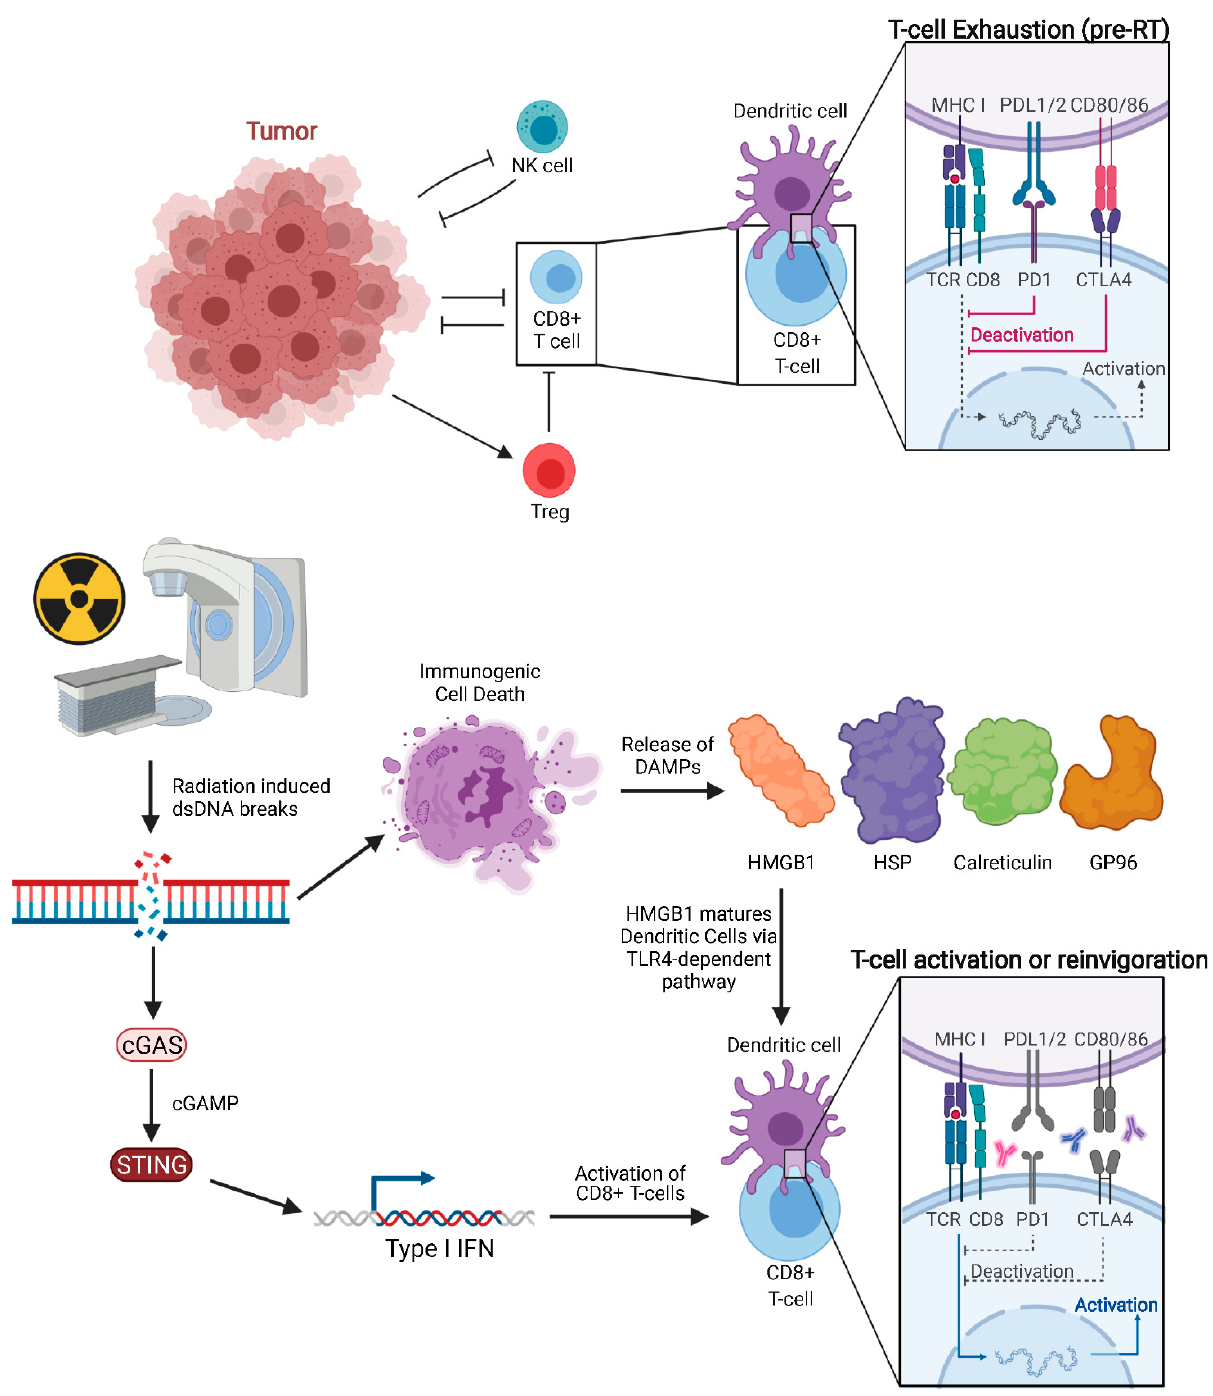
Figure 2. Pre-treated tumor with exhausted CD8 + T cells and tumor proliferating without immune inhibition. Radiation of tumors leads to double-stranded DNA breaks and downstream cGAS-STING signaling, which in turn increases Type 1 IFN release. Immunogenic cell death releases DAMPs such as HMGB1, HSP, GP96, and calreticulin. HMGB1 activates Dendritic Cells through TLR4-dependent pathway. Anti-CTLA-4 agents act on naïve and regulatory T cells while anti-PD-1 agents predominantly work on exhausted T cells.